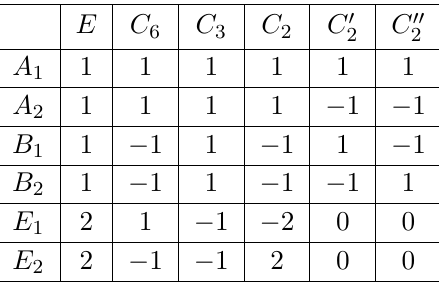
Table 1 . Table of characters for dihedral group D 6